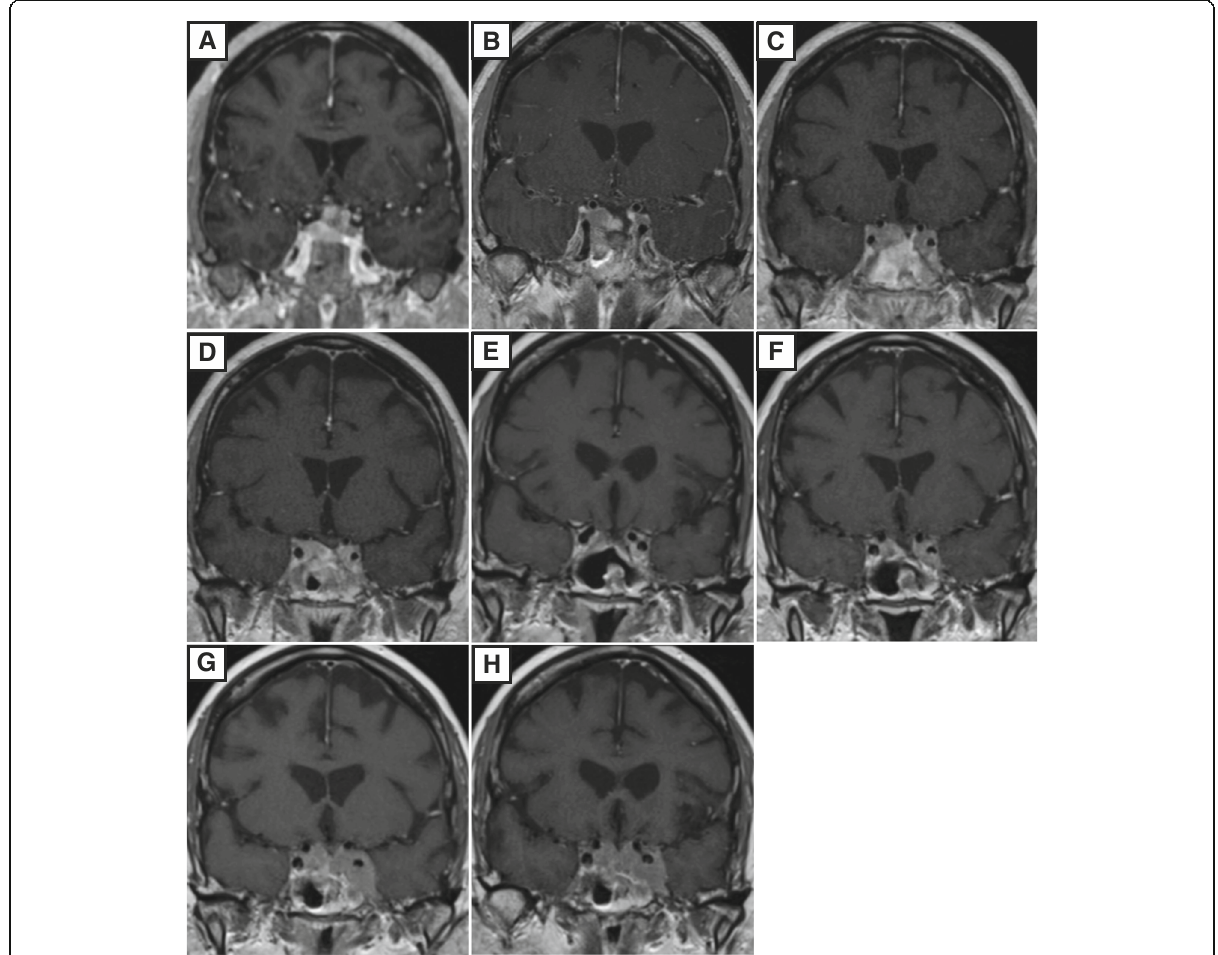
Fig. 1 MRI of the pituitary throughout the patient ’ s clinical course. Coronal T1-weighted post-gadolinium images are shown. After partial resection at another facility, she presented to us for more definitive endoscopic endonasal resection of the residual sellar tumor ( a ), which was successful ( b ). She then underwent radiation therapy 3 months after this repeat surgery, at which point her cavernous sinus residual disease had already subtly progressed ( c ). Radiation therapy was initially successful for local control of disease 3 months after completion of fractionated IMRT ( d ). Two months following this MRI, her ACTH levels increased dramatically despite stability of her cavernous sinus residual disease ( e ), and metastasis to the liver was diagnosed (see Fig. 4). Six months after resection of the liver metastasis, her sellar and cavernous sinus disease remained stable ( f ), but then quickly progressed over the next 6 months ( g ). She was started on dual-agent oral chemotherapy, and 8 months later her local disease was stable ( h ), although she has suffered additional liver